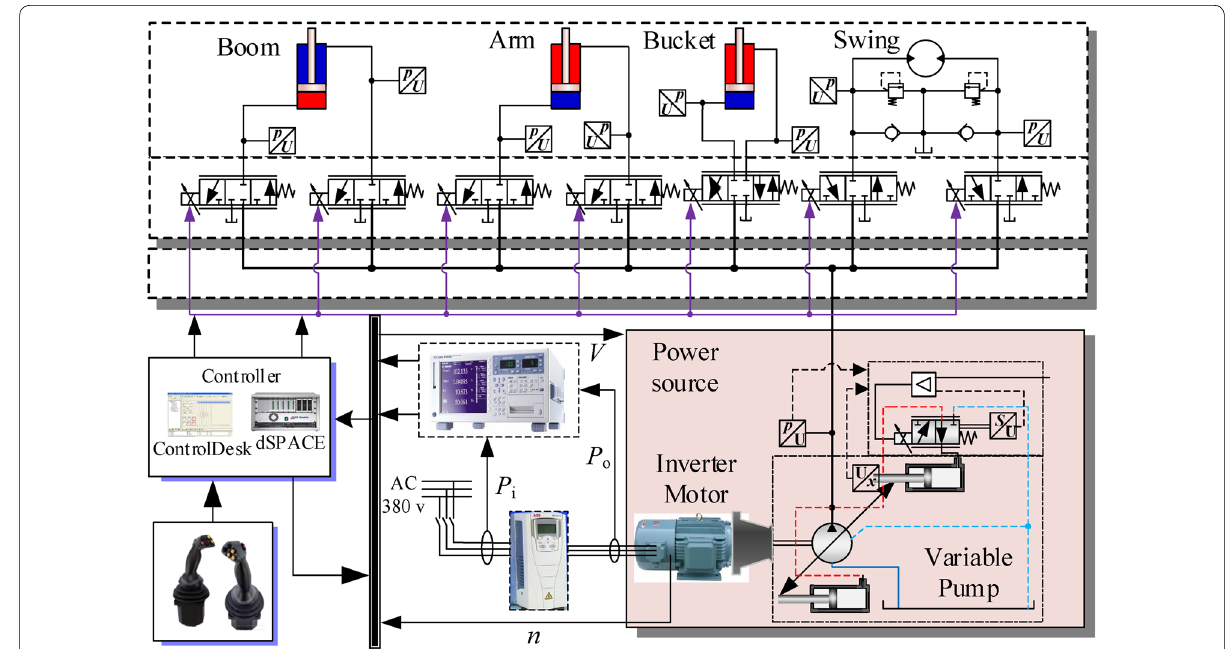
Figure 1 Working principle of electro-hydraulic